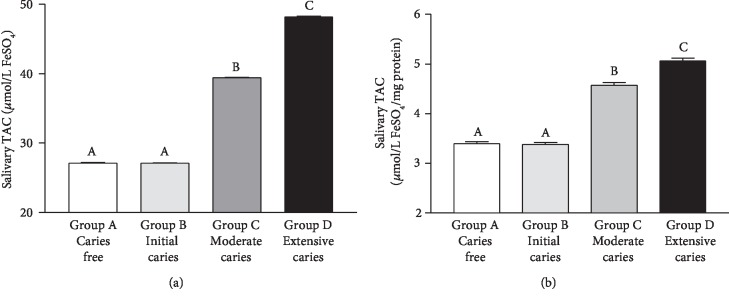
Total Antioxidant Capacity (TAC) (in μmol/L FeSO4 for the graph in (a) and in μmol/L FeSO4/mg protein for the graph in (b)) in saliva samples of caries-free children (Group A) and in those with caries at different stages (Groups B-D). Bars represent the mean ± SD. Equal letters represent statistical similarity (p > 0.05) and different letters mean statistical differences (p < 0.001).